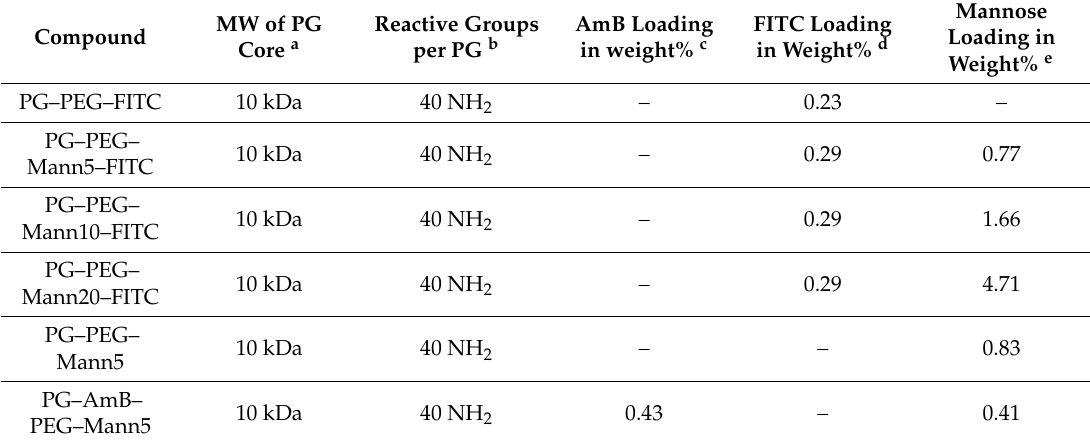
Table 1. Summary of characteristics of precursors and